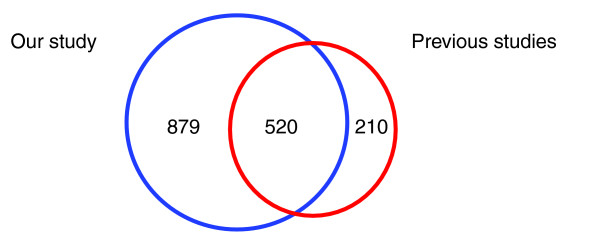
Comparison between proteins identified in the present study and five recently published proteomic datasets.